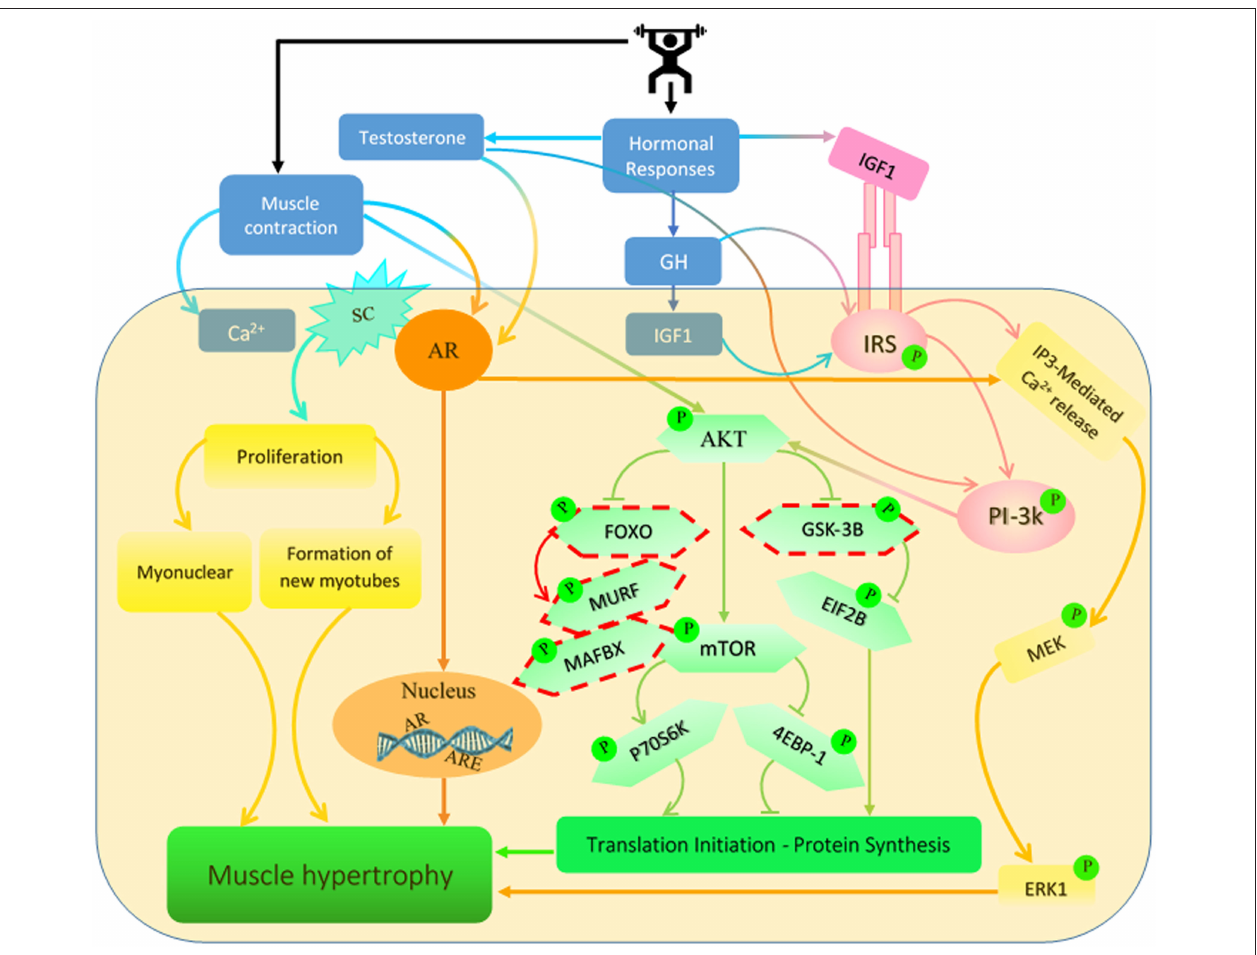
FIGURE 1 | Signaling pathways regulated by testosterone, growth hormone (GH) and insulin-like growth factor 1 (IGF-1) are induced by resistance exercise (RE). RE has been shown to increase the concentration of these hormones which activate several different signaling pathways in the muscle. These pathways lead to increases in muscle protein synthesis (MPS) and net protein accretion which result in an increase in muscle mass. SC, satellite cell; AR, androgen receptor; IRS, insulin receptor substrate; ARE, androgen response element. *Dashed outline represents inhibitory protein